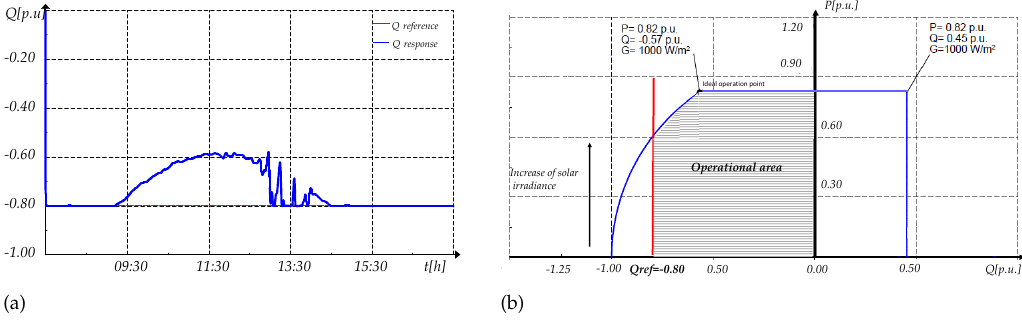
Figure 23. Absorbed reactive power when MPPT is considered ( a ) Maximum possible reactive power and ( b ) Operational area.